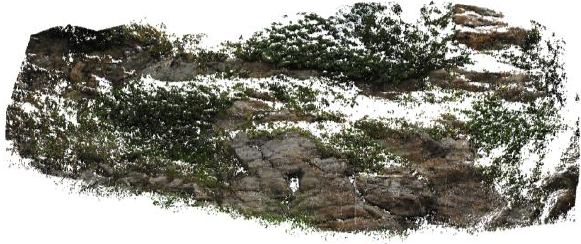
Figure 19. SURE Nikon dense point cloud